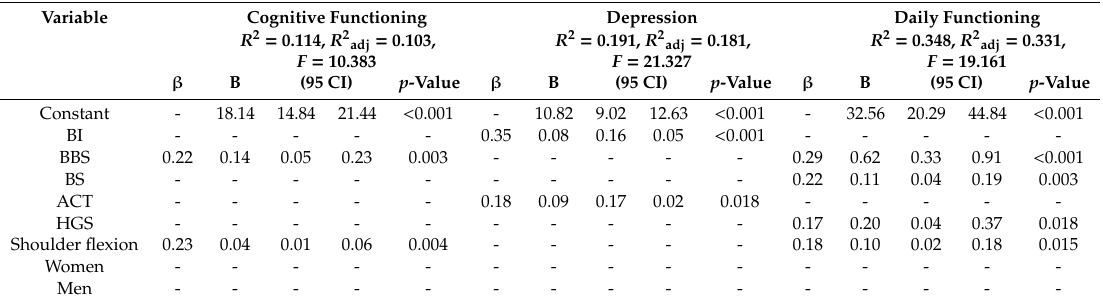
Table 3. Independent variables associated with cognitive functioning, depression and daily functioning of the